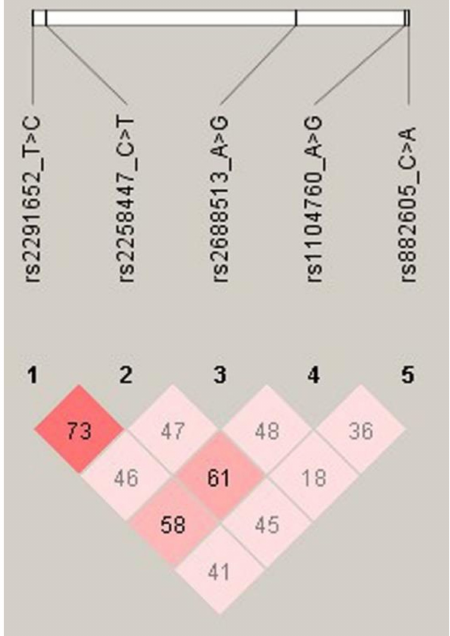
Figure 1. The linkage disequilibrium (LD) block structure consisted of the five SNPs located in MUC4